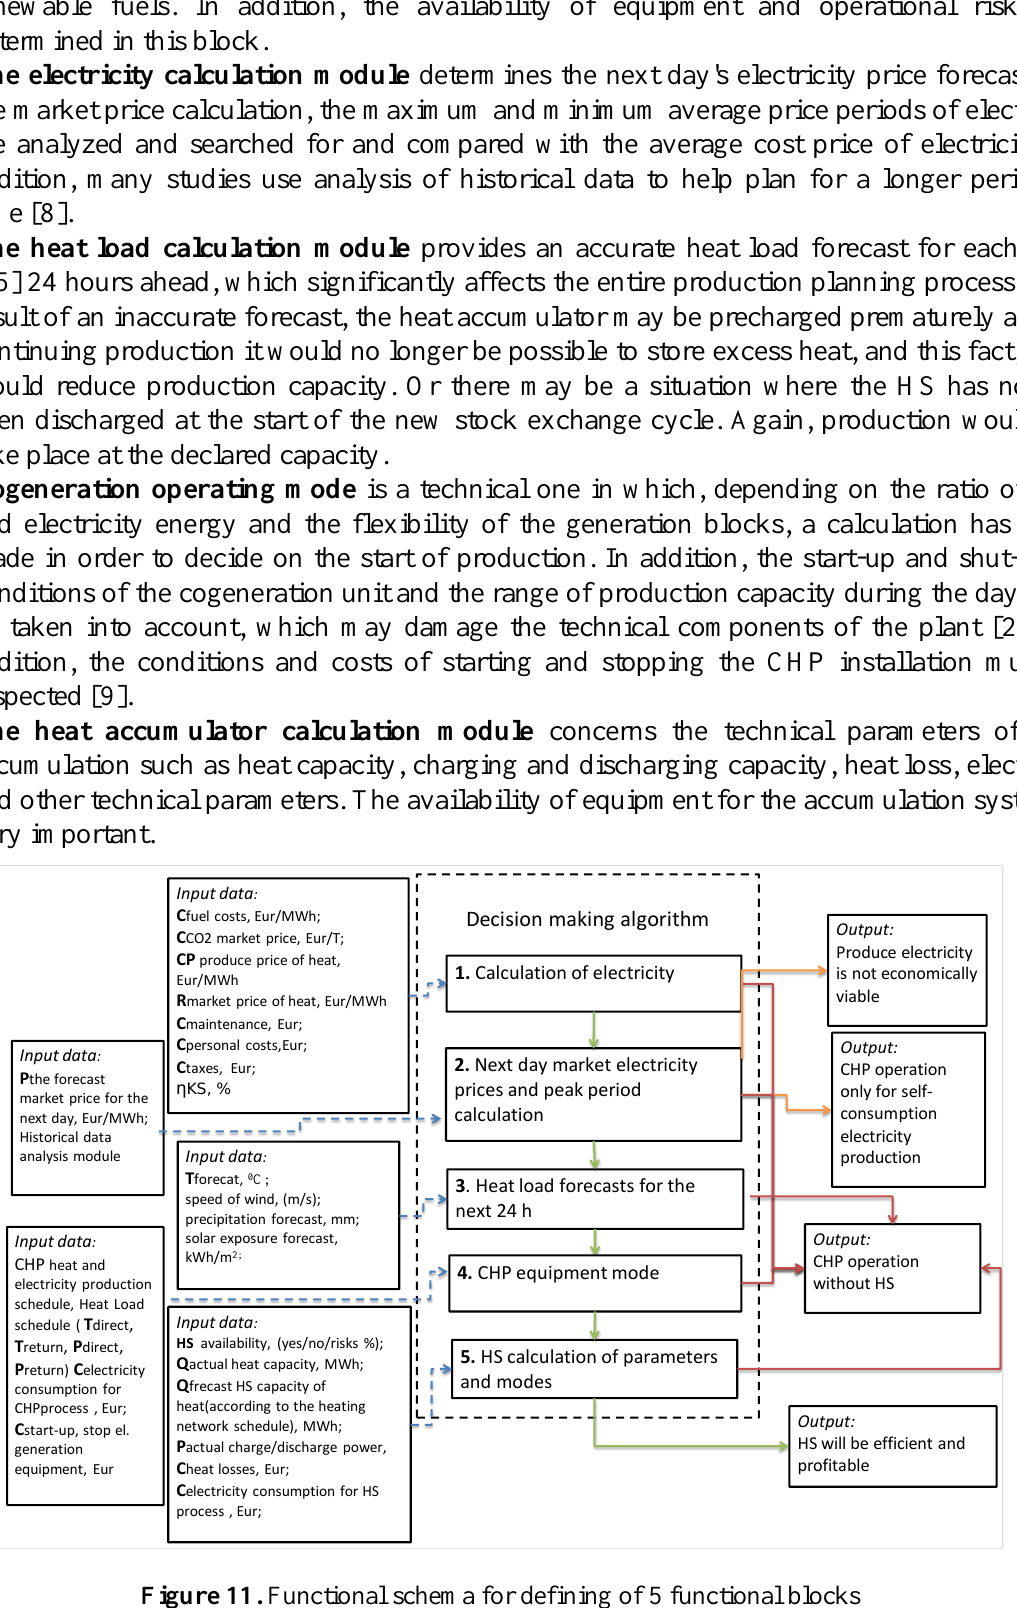
Figure 11. Functional schema for defining of 5 functional